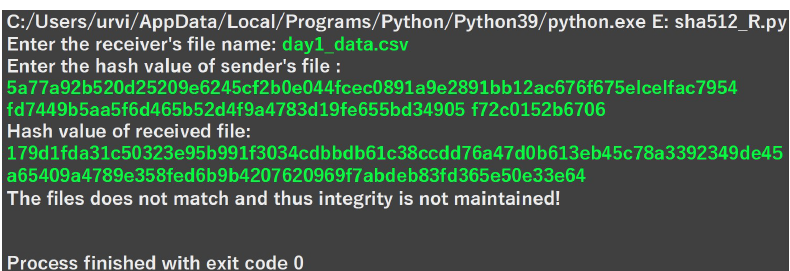
Figure 8. Receiver received the original data.